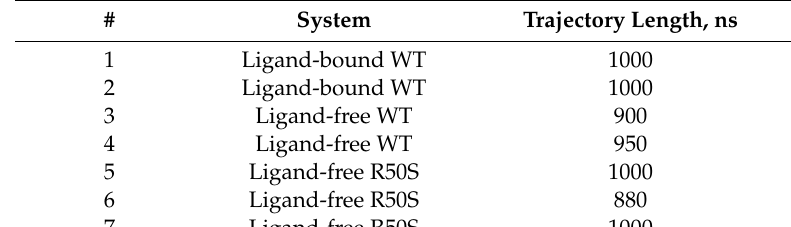
Table 2. The list of performed simulations.